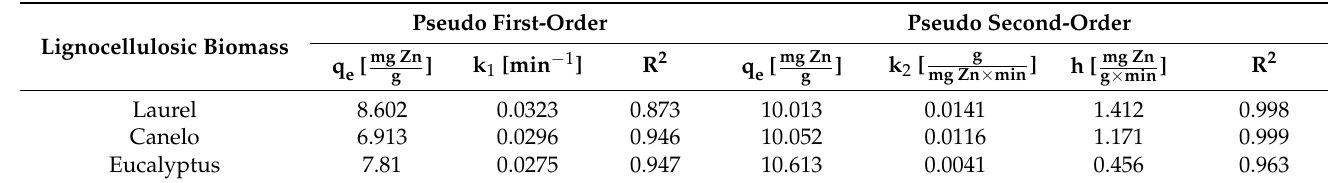
Table 2. Kinetics parameters for Zn(II) ions removal using the magnetite impregnated adsorbents. Pseudo First-Order Pseudo Second-Order Lignocellulosic Biomass Laurel